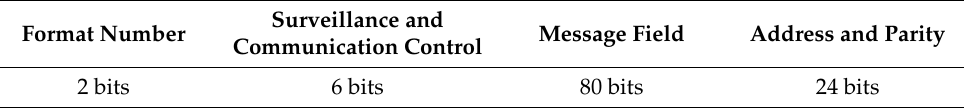
Table 3. Mode S Data Block Surveillance Communication Interrogation and Reply—Extended Length Message Format